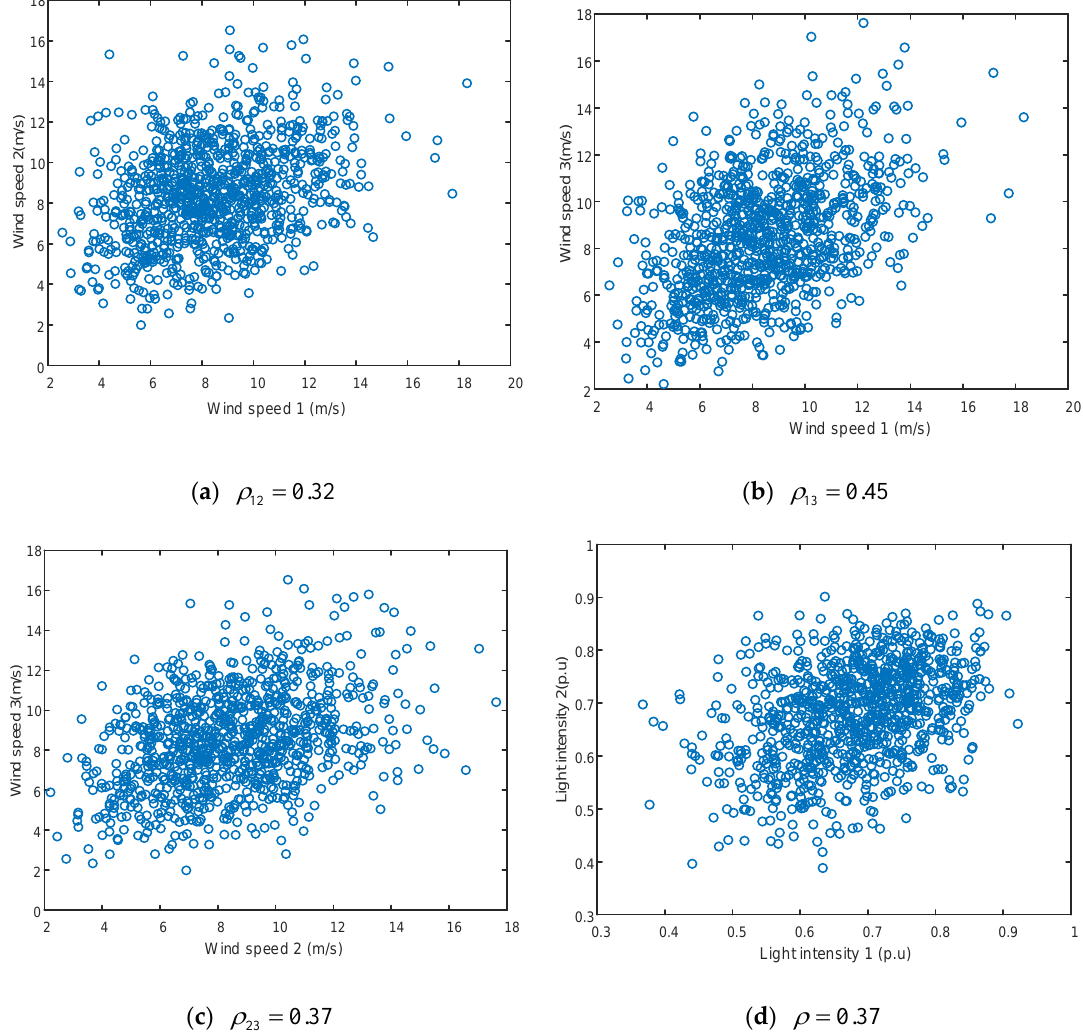
Figure 4. Results for point estimate method with the Nataf transformation for Case 1. Correlations in the wind speeds of ( a ) wind power plants 1 and 2, ( b ) wind power plants 1 and 3, and ( c ) wind power plants 2 and 3. ( d ) Correlation in the light intensity for the photovoltaic power plants.